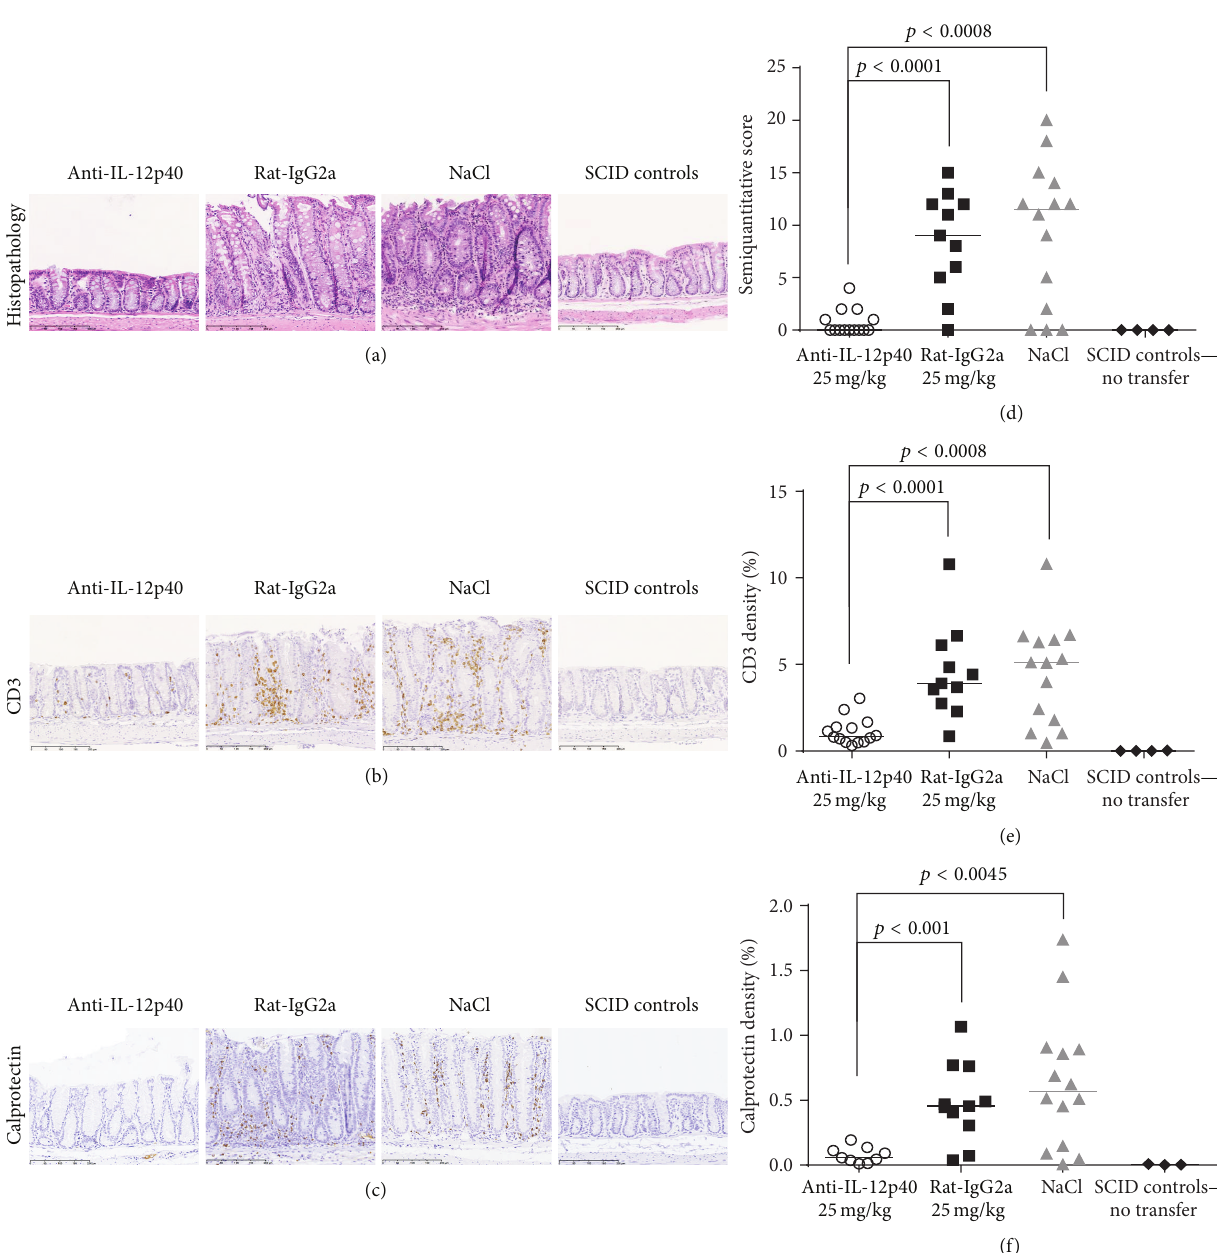
colonic sections were stained for a T cell marker (CD3).